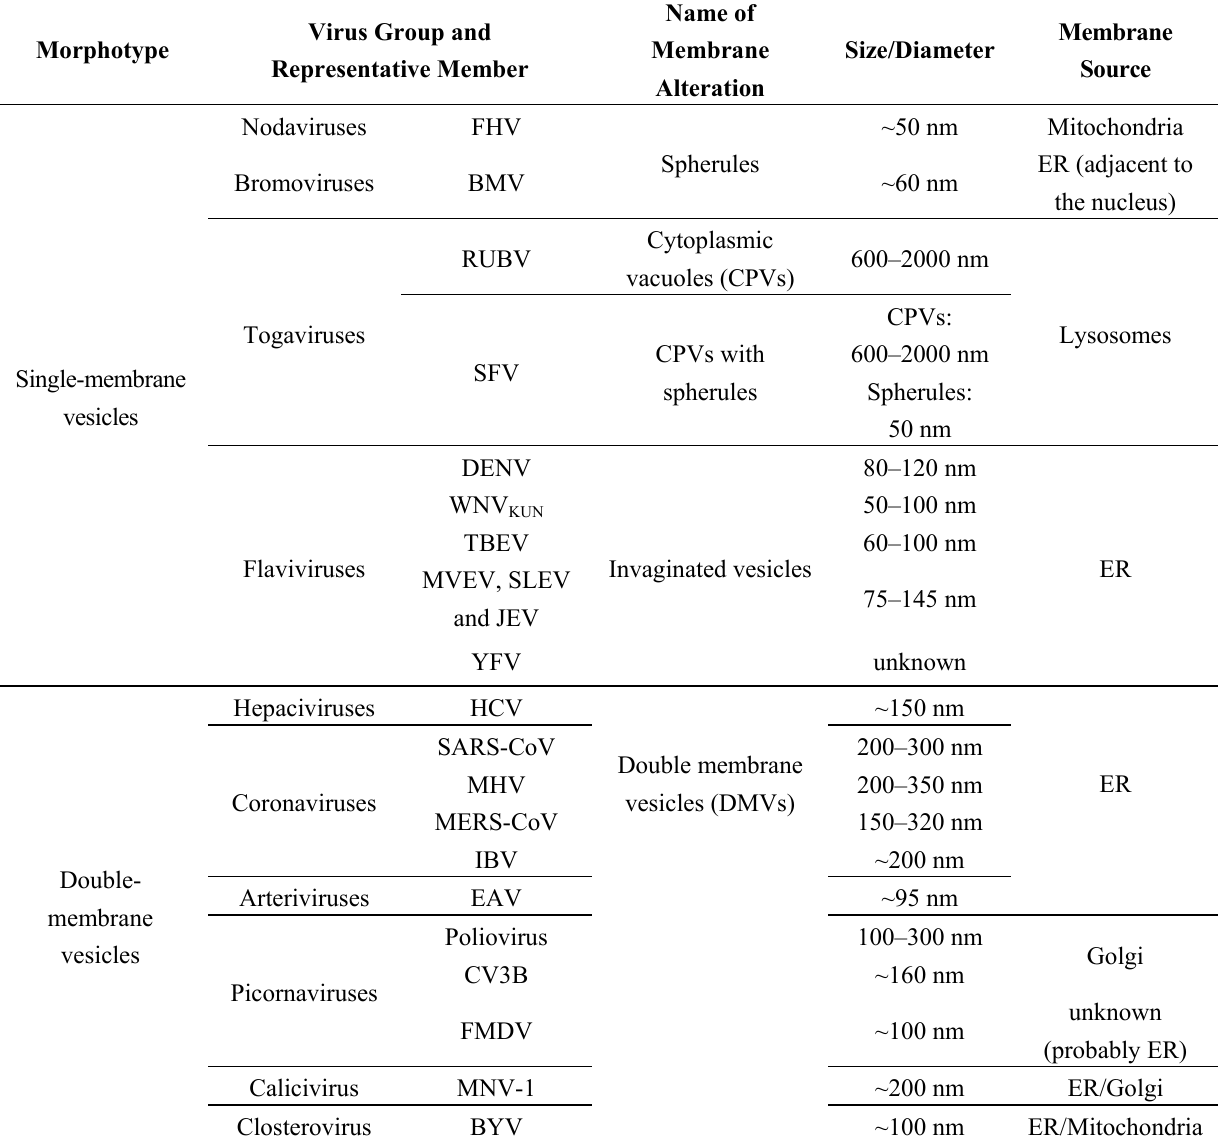
Table 1. Main structures induced by different (+) strand RNA